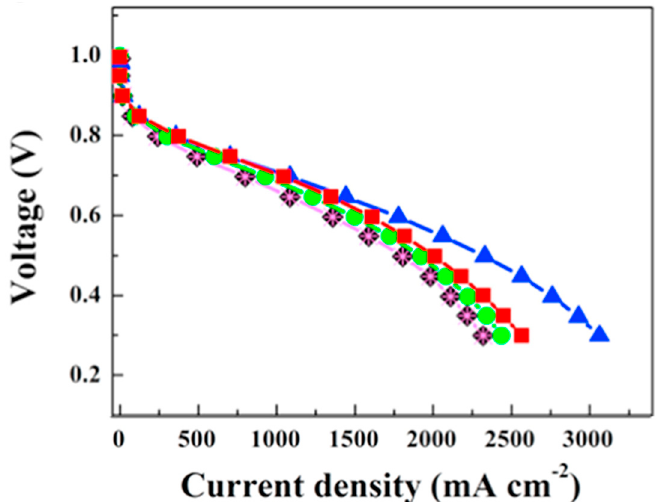
Figure 5. Polarization plots of Nafion 212 (black), recast Nafion (pink), Nafion TNT 10% (blue), Nafion TNT 20% (red), Nafion TNT 50% (green) at 80°C and 100% RH; reproduced with permission TNT 20% (red), Nafion TNT 50% (green) at 80 ◦ C and 100% RH; reproduced with permission from from [156].